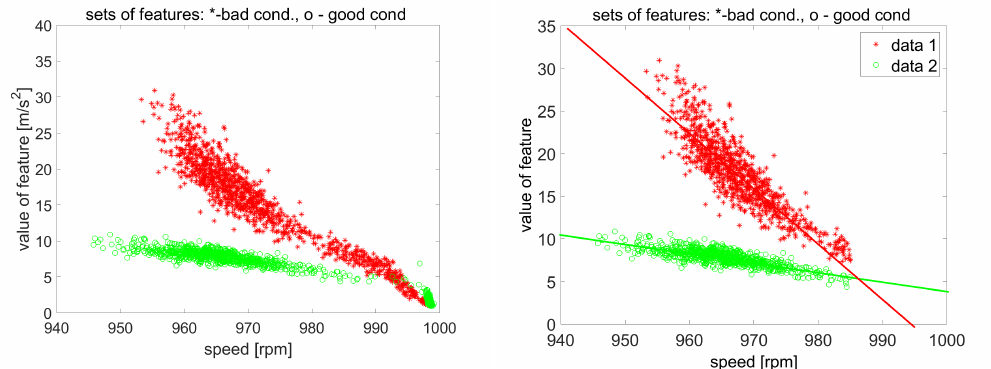
Figure 5. Method of classification in two-dimensional space: ( left )—whole data, ( right )—data for a limited speed range